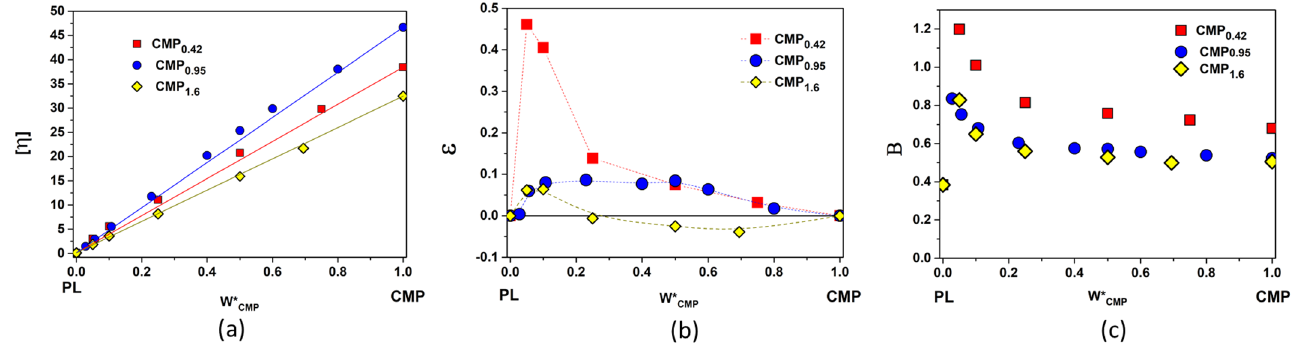
Figure 3. Intrinsic viscosities obtained for PL/CMP 0.42 , PL/CMP 0.95 and PL/CMP 1.6 mixtures at 37 ◦ C—the lines represent ideal intrinsic viscosities calculated according to Equation (2) ( a ). The variation of parameter ε ( b ) and parameter B ( c ) with the composition of the mixtures (obtained at 37 ◦